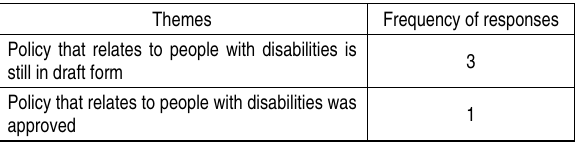
Table 2. Stage of policy